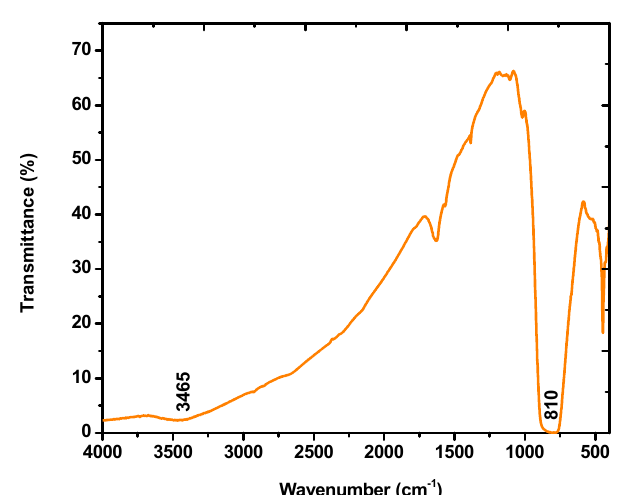
Fig. 7. Fluorescence spectra of the synthesized CeVO Fig. 7 Fluorescence spectra of the synthesized CeVO 4 NPs